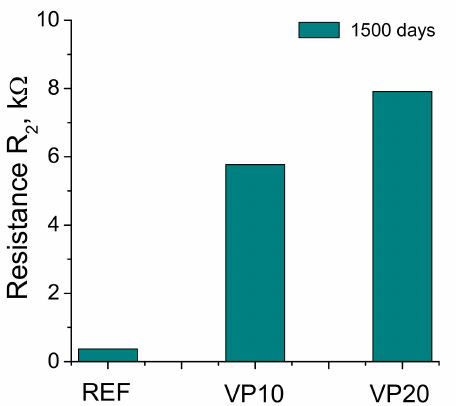
Figure 8. Resistance R 2 results noted for the mortars